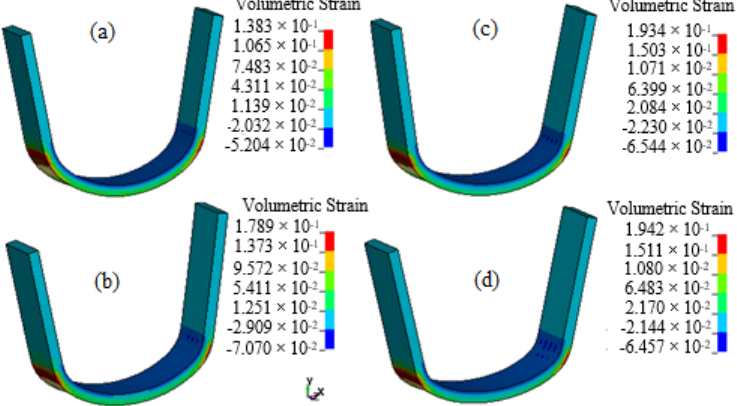
Figure 10. Contour plots of short beam configuration for volumetric strain at different loading rates ( a ) 0.05 mm/s, ( b ) 0.5 mm/s, ( c ) 5 mm/s, and ( d ) 10 mm/s.